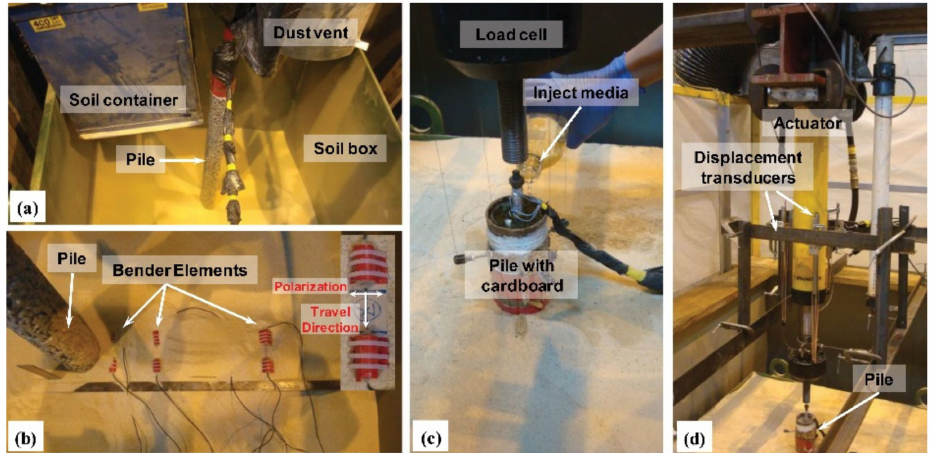
Figure 6. Detailed device drawing for large MICP grouting ( a ) soil raining; ( b ) bender element installation; ( c ) media injected from the top of the pile; ( d ) pull-out loading setup [24].